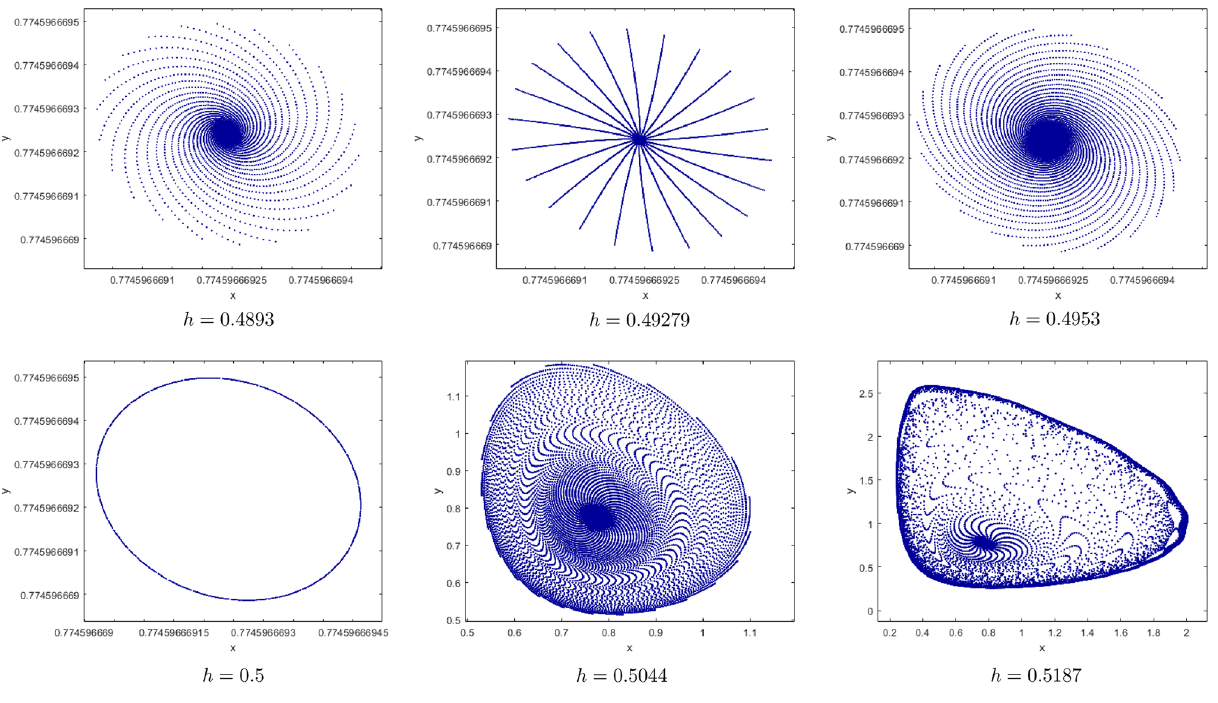
Figure 11. The phase portraits associated with Fig. 10(i), (ii).